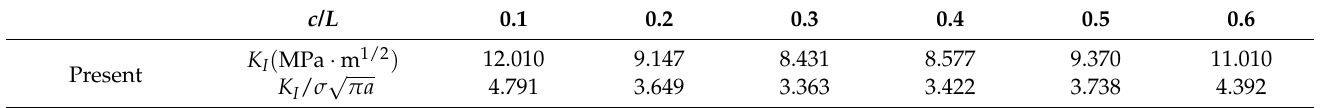
Figure 5. ( a ) Rectangular plate with the offset double-edge cracks; ( b ) Global and local meshes (the total number of elements is 142). Table 5. SIFs with different crack spacing ( L / W =